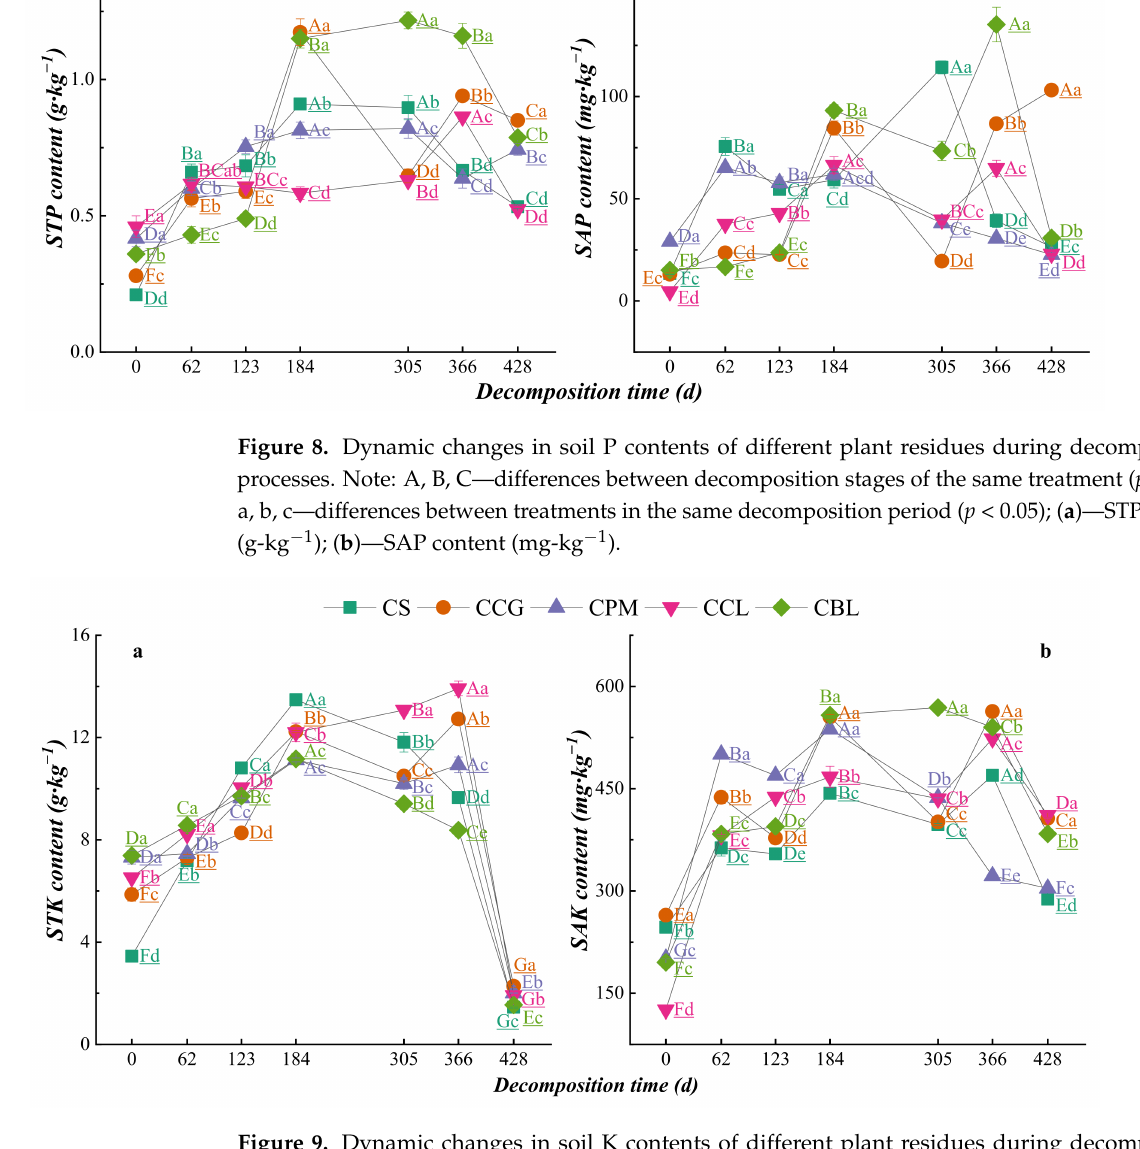
Figure 9. Dynamic changes in soil K contents of different plant residues during decomposition processes. Note: A, B, C—differences between decomposition stages of the same treatment ( p < 0.05); a, b, c—differences between treatments in the same decomposition period ( p < 0.05); ( a )—STK content (g-kg − 1 ); ( b )—SAK content (mg-kg − 1